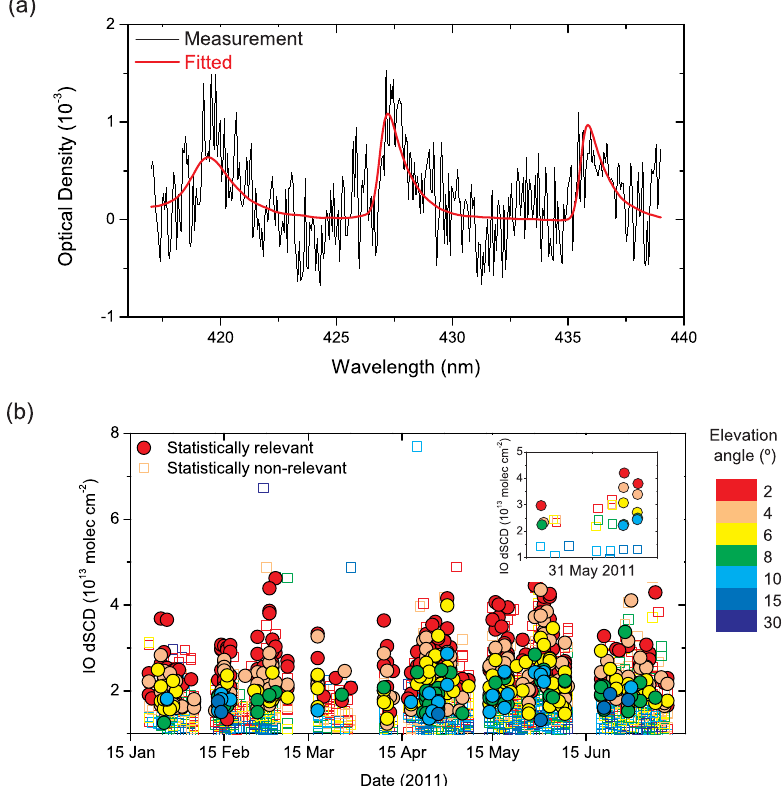
Figure 3. Retrieval of IO during the Malaspina 2010 circumnavigation. (a) Example of a typical IO spectral fit during the expedition. The particular spectrum was taken on 31 May 2011 (15:00LT, 53 ◦ SZA) in the eastern Pacific for a 2 ◦ elevation angle. The black line represents the measured IO optical density and the red line represents the fitted IO after the DOAS retrieval. This fit resulted in an IO dSCD of (3.8 ± 0.3) × 10 13 molecules cm − 2 (i.e. IO vmr of 0.8 ± 0.1pmolmol − 1 ) with a residual optical density of 3.9 × 10 − 4 (root mean square). (b) Timeline of the IO dSCD observed during the expedition. Statistically relevant data (i.e. data above the quality filters; see the Supplement) are shown with filled circles and the non-relevant data with empty squares. The inset shows the daily evolution of IO dSCD for 31 May 2011. The colour code indicates the elevation angle of the